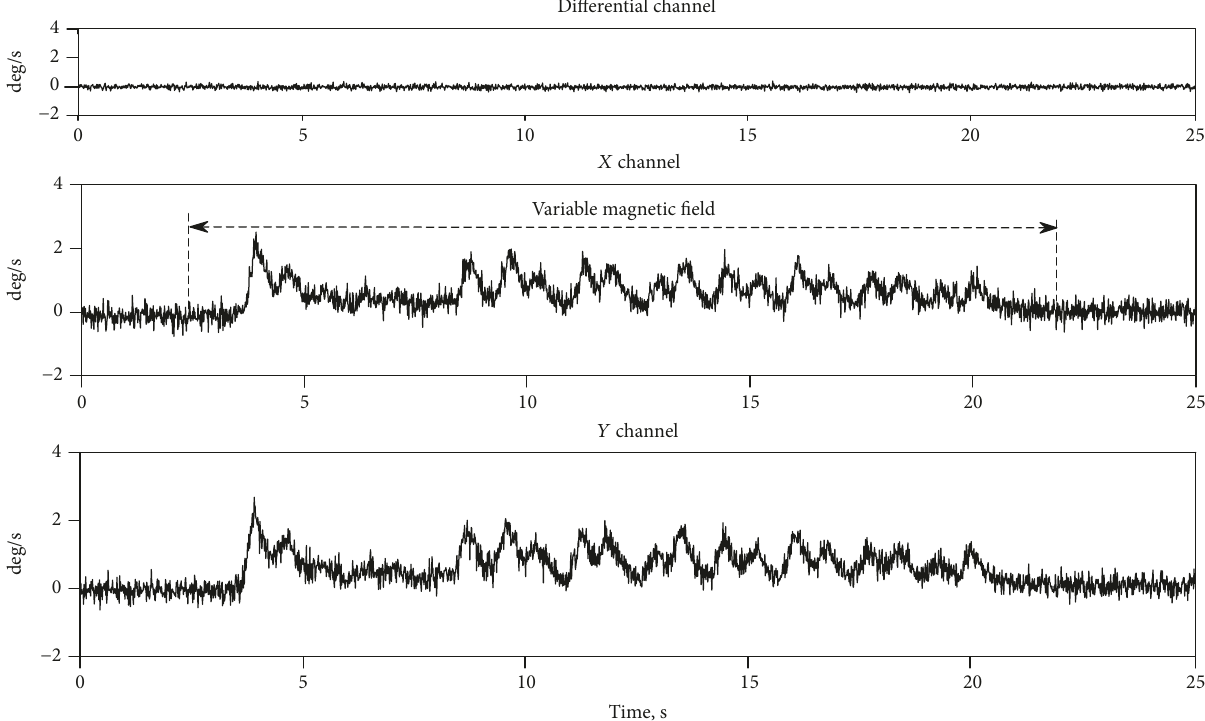
Figure 15: The X , Y , and di ff erential channel responses to a variable magnetic fi eld applied.